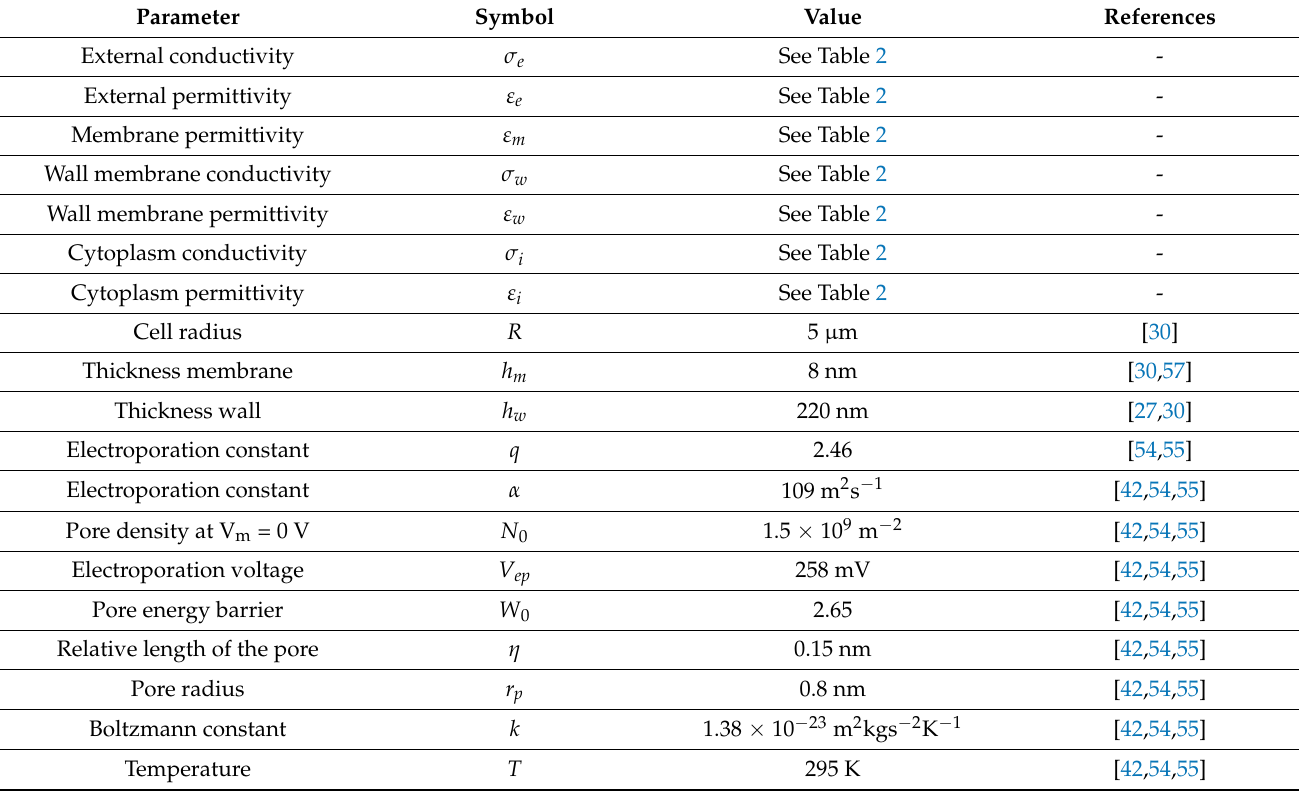
Table A1. Non-linear electroporation model, electrical and geometric parameters of simulation.